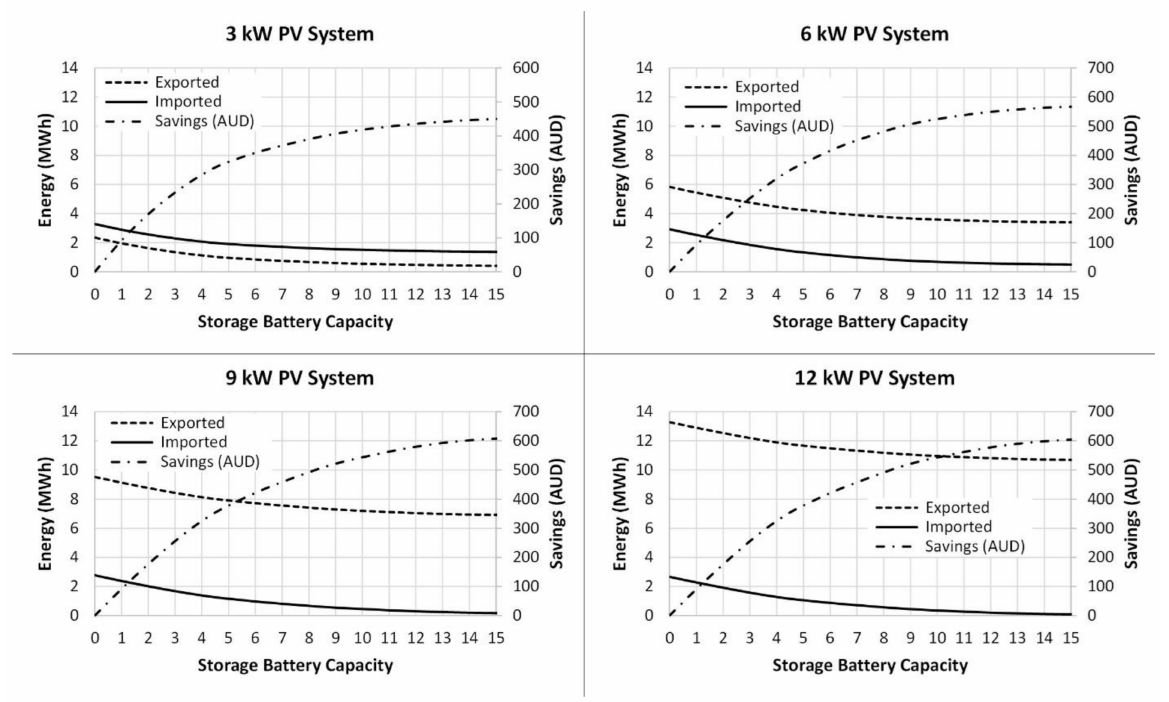
Figure 5. Energy flows and cost savings as a function of battery size and PV system